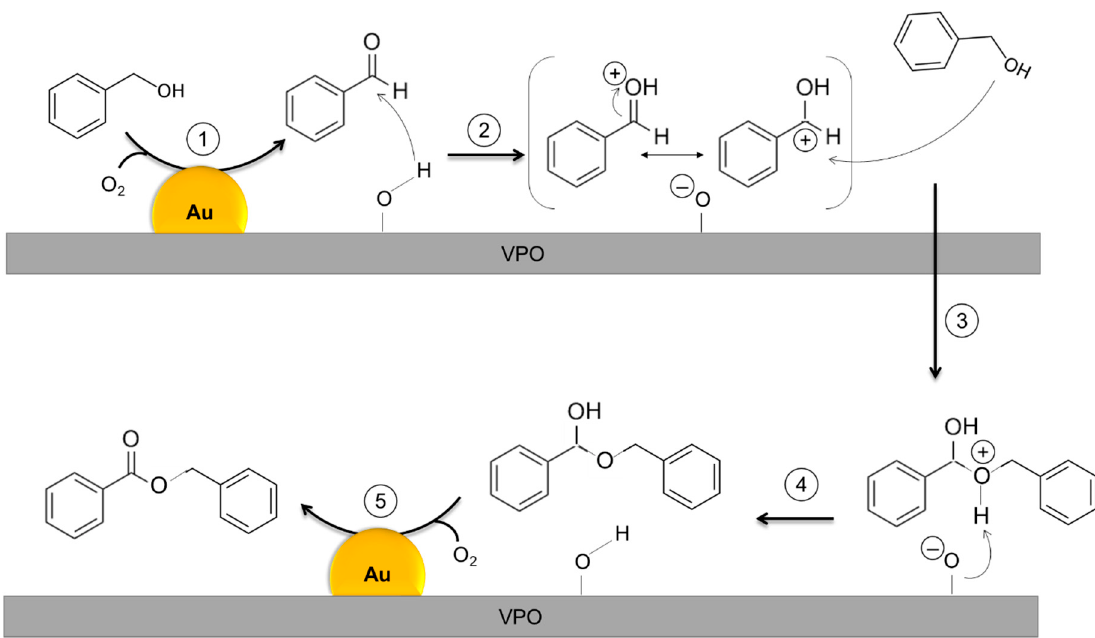
Figure 2. Products distribution for ( a ) 1% Au IW /VPO and ( b ) 1% Au IW /AC catalysts.